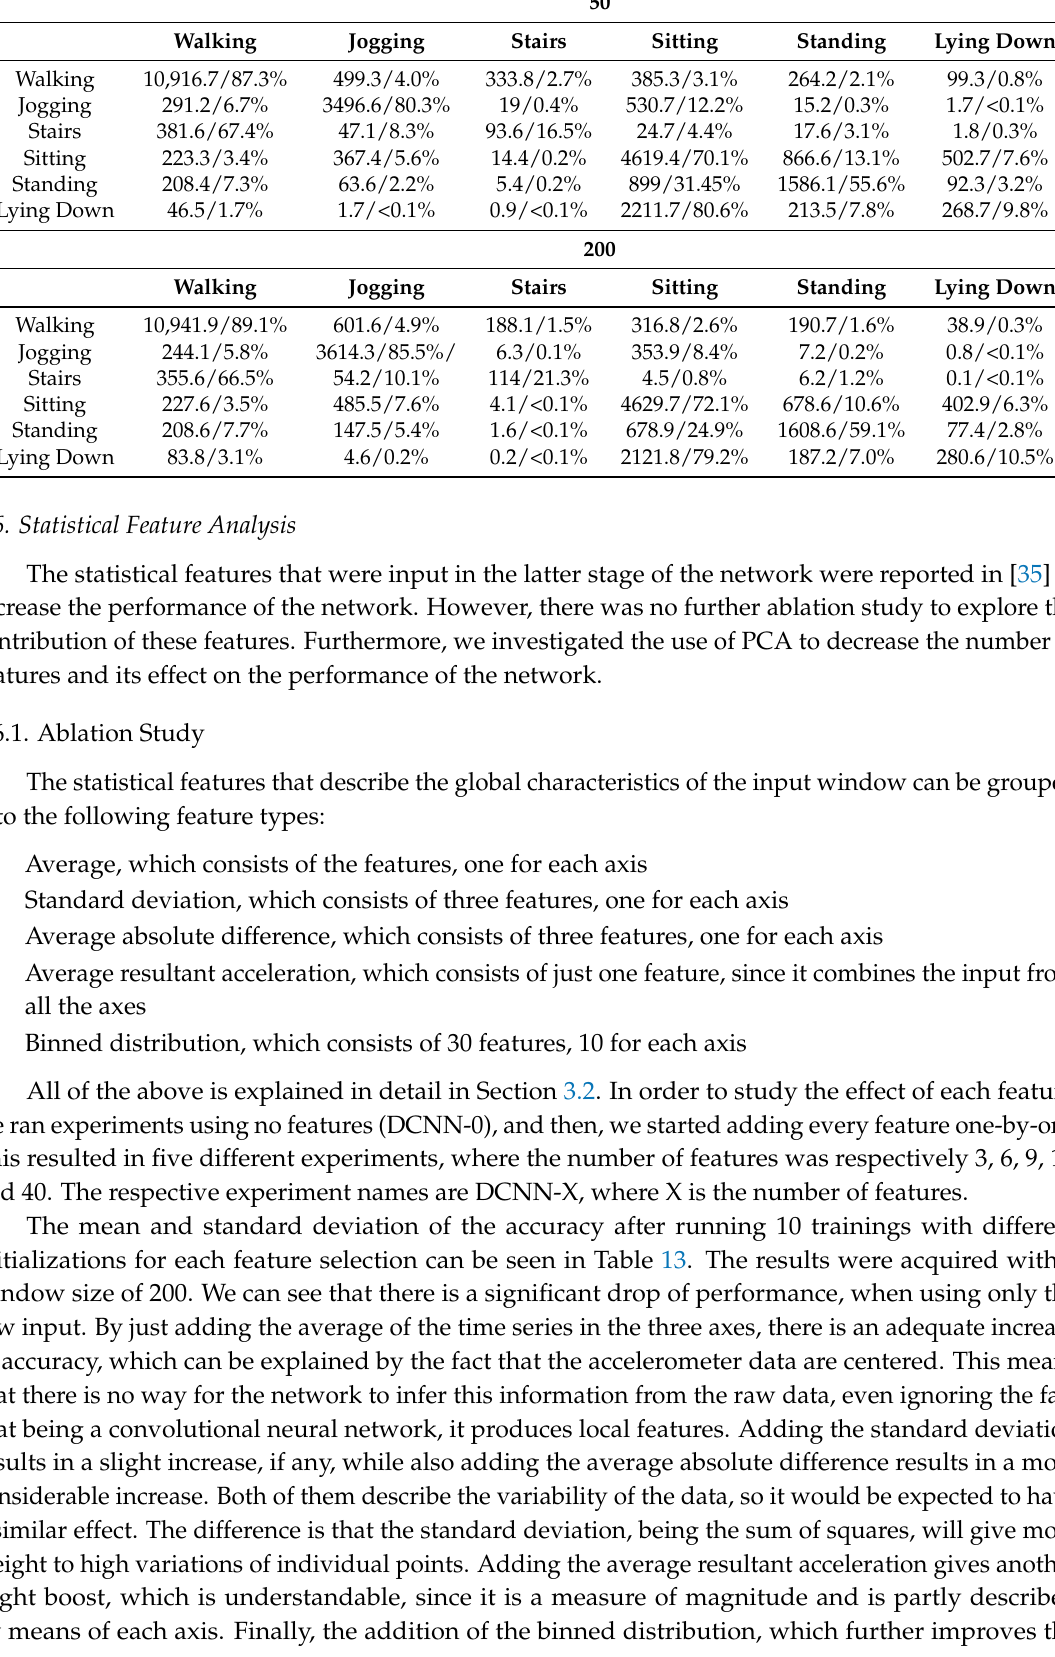
Table 12. Confusion matrix of the 10-fold cross-validation of the Actitracker dataset.